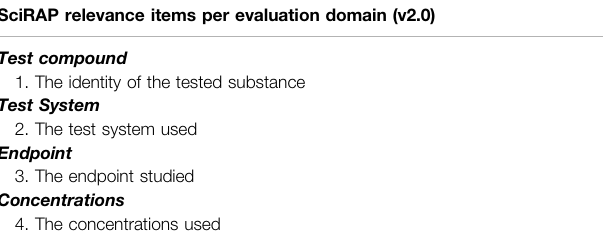
TABLE 3 | SciRAP items for assessing relevance of in vitro toxicity studies for health hazard or risk assessment (tool version 2.0). SciRAP relevance items per evaluation domain